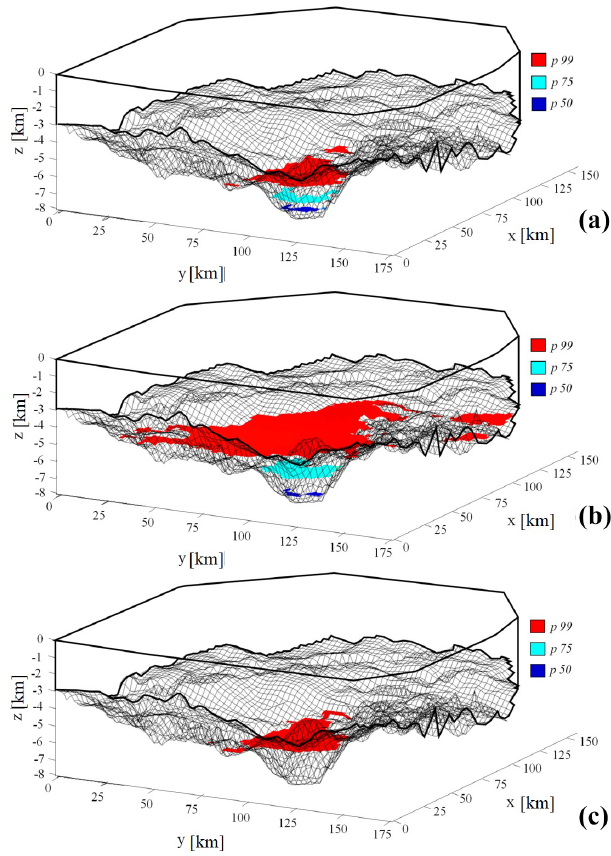
Figure 8. Three-dimensional illustration of activation surfaces yielded by pp 50 ( CO 2 ) (dark blue), pp 75 ( CO 2 ) (light blue) and pp 99 ( CO 2 ) (red) for CCR1 (a) , CCR2 (b) and CCR3 (c) .